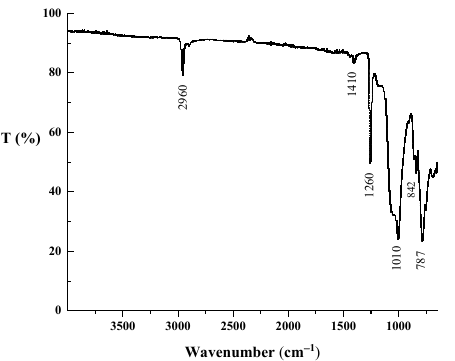
Figure 1. FTIR spectra of prepared DVB/Carbon/PDMS SPME coating.